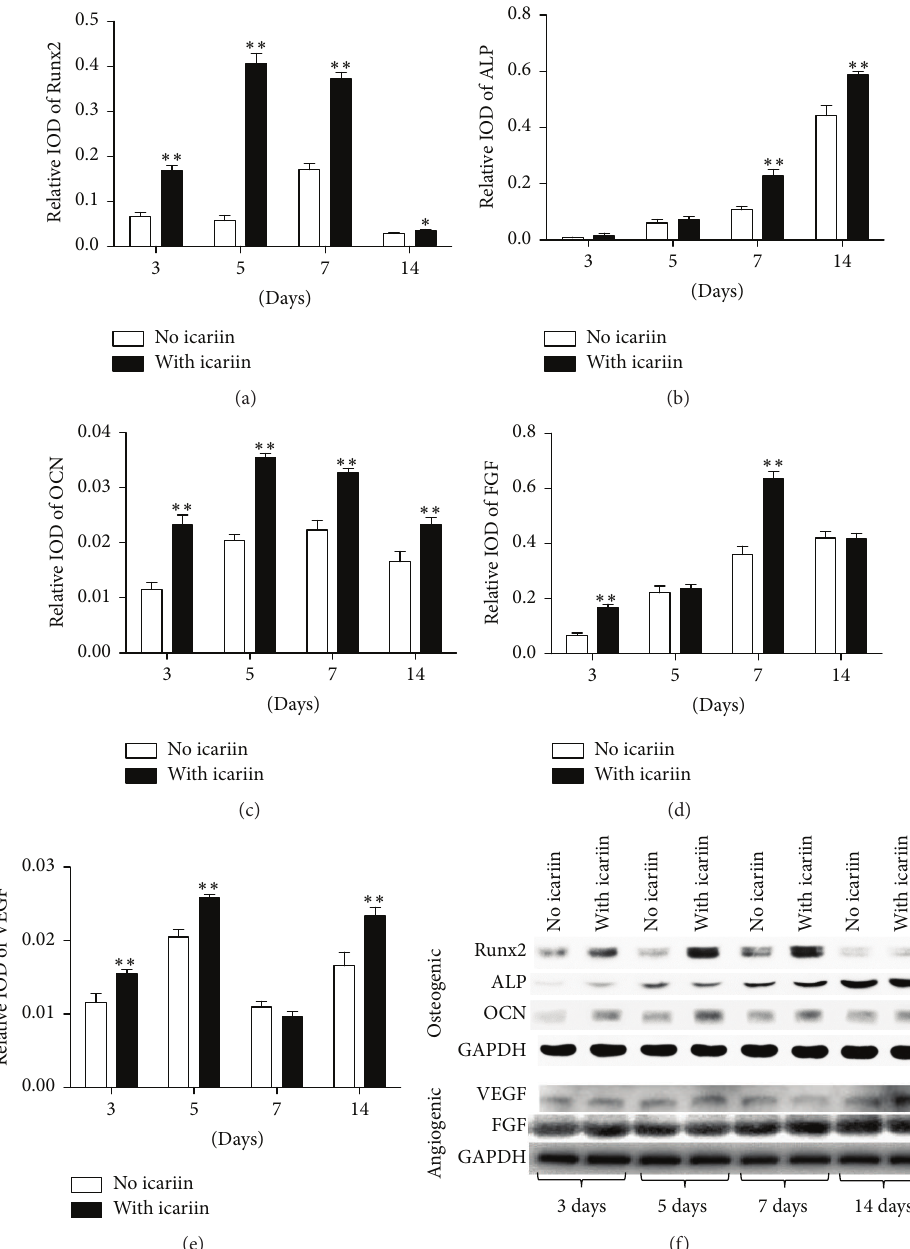
Figure 4: Graphs depicting the fold changes of the expression of osteogenesis-related and angiogenesis-related proteins in BMSCs under the stimulation of 10 −6 mol/L icariin for 3 days, 5 days, 7 days, and 14 days. (a) Runx2, (b) alkaline phosphatase (ALP), (c) osteocalcin (OCN), (d) fibroblast growth factors (FGF), (e) vascular endothelial growth factor (VEGF), and (f) photographs of western blot analysis from a representative experiment. All data are presented as mean values together with the standard deviation (SD). ∗ 𝑝 < 0.05 ; ∗∗ 𝑝 < 0.01 indicating the statistical difference between the experimental group (with icariin) and the control group (no icariin) at the same time